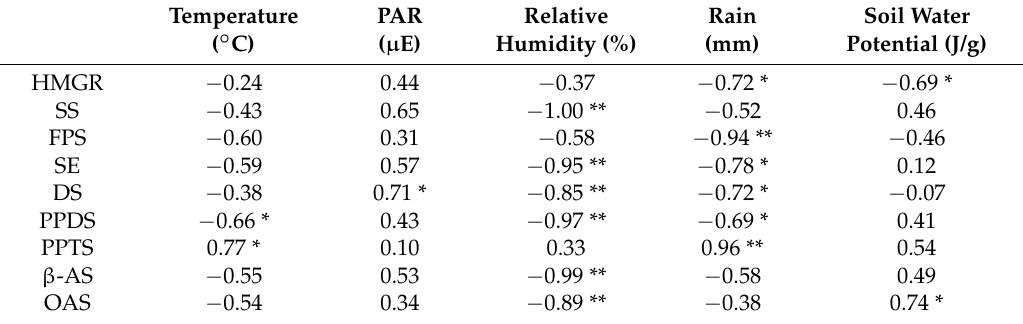
Table 10. Correlation analysis between environmental factors and gene expression in leaves at different growth times. Temperature PAR Relative Rain ( ◦ C) ( µ E) Humidity (%)